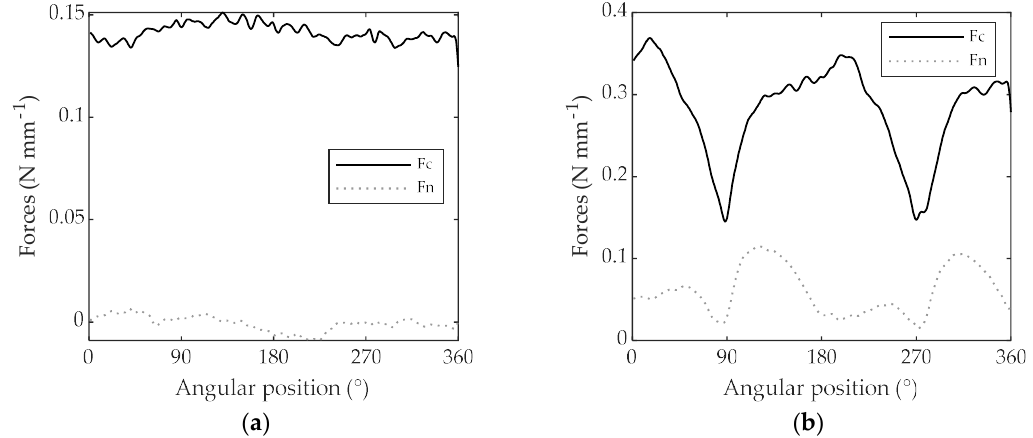
Figure 8. Cutting force and normal forces in up-milling with a depth of cut of 1.5 mm machining: ( a ) PTFE; ( b ) beech LVL.